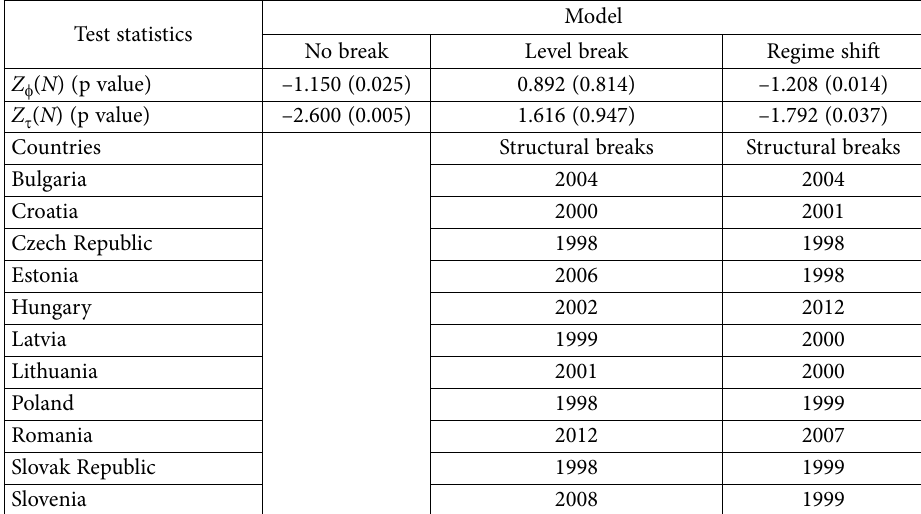
Table 6b. Results of Westerlund and Edgerton’s (2008) cointegration test (Model